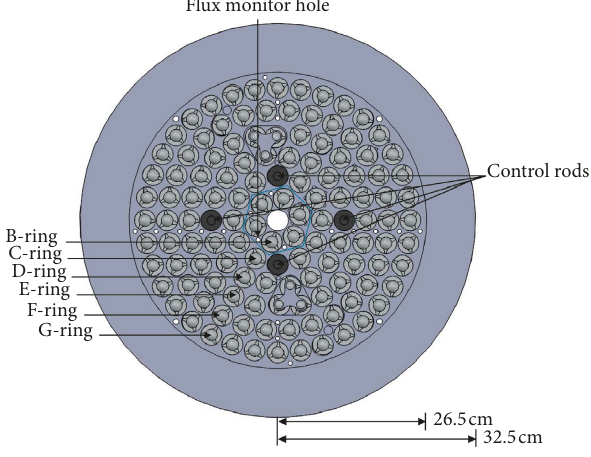
Figure 19: Flux monitor hole location.